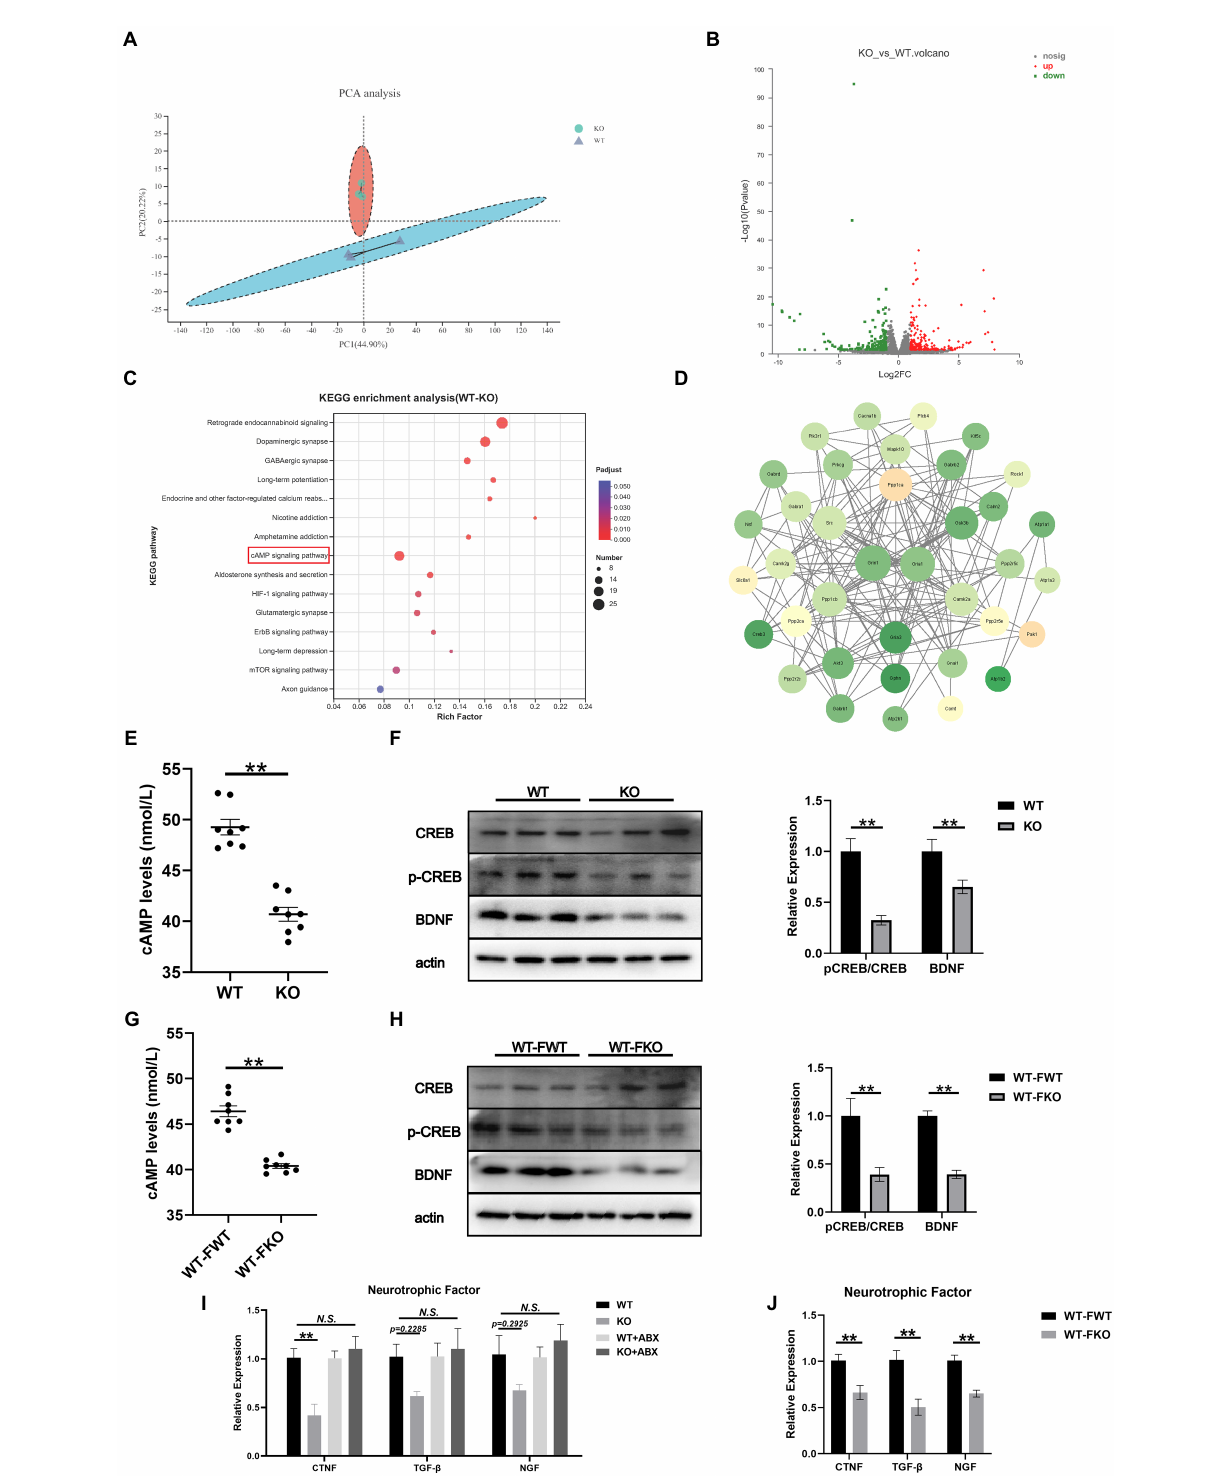
FIGURE 5 cAMP/CREB/BDNF signaling mediated depression-like behaviors in Sig-1R knockout mice. (A) PCA of the RNA-seq data. (B) Volcano plots of the DEGs from RNA-seq, with 241 upregulated and 204 downregulated. Red color intensity signifies upregulation of gene expression, and green signifies downregulation. (C) Mapping of the RNA-seq data to the KEGG pathway (KEGG). The vertical axis represents the pathway names, while the horizontal axis represents the enrichment factor. The size of the point indicates the number of DEGs in the pathway, and the color of the point corresponds to a different Q -value range. (D) PPI network analysis. The darker color indicates a higher core degree. (E) cAMP levels in WT and KO group. (F) Western blotting and statistical analysis of cAMP/CREB/BDNF signaling pathway in WT and KO group. (G) cAMP levels in FMT recipient mice. (H) Western blotting and statistical analysis of cAMP/CREB/BDNF signaling pathway in FMT recipient mice. (I,J) RT-qPCR for the expression of neurotrophic factors CTNF, TGF- β , and NGF [CTNF F (3, 12) = 9.073, p = 0.0021; TGF- β F (2, 15) = 2.413, p = 0.1174. F (2, 15) = 2.395, p = 0.1192. One-way ANOVA]. ** p < 0.05. N.S. : not